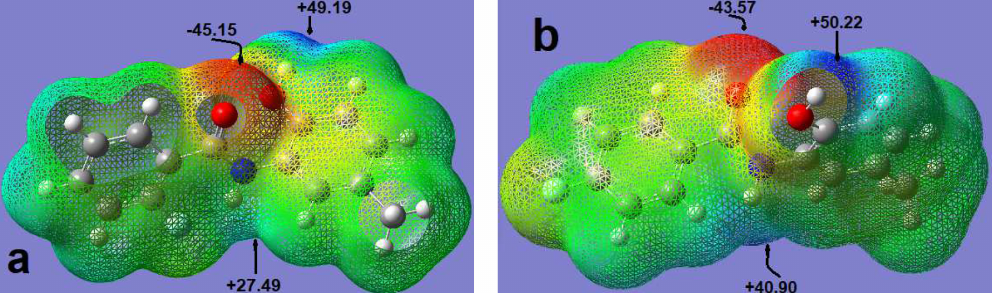
Figure 8. Three-dimensional representation of the electrostatic potential around the molecules ( a ) o -FPhB ; ( b ) p -FPhB . Values are given in kcal/mol.